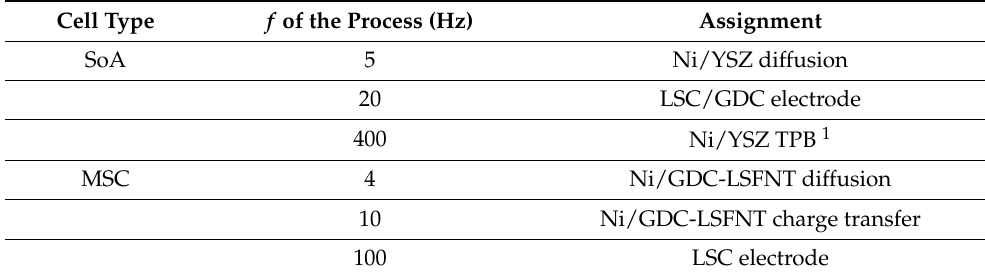
Figure 4. EIS of the metal supported cell ( a ) Nyquist plot, ( b ) Bode plot, and at 650 °C, 20% and 4%H 2 O/H 2 to the fuel electrode vs. O 2 and air to the oxygen electrode, and ( c ) Delta (difference) Bode plot, 20% vs. 4% fuel humidity to the fuel electrode and air vs. O 2 to the oxygen electrode. Table 1. Characteristic frequencies of electrode contributions to the total ASR determined from gas shift EIS at 650 ◦